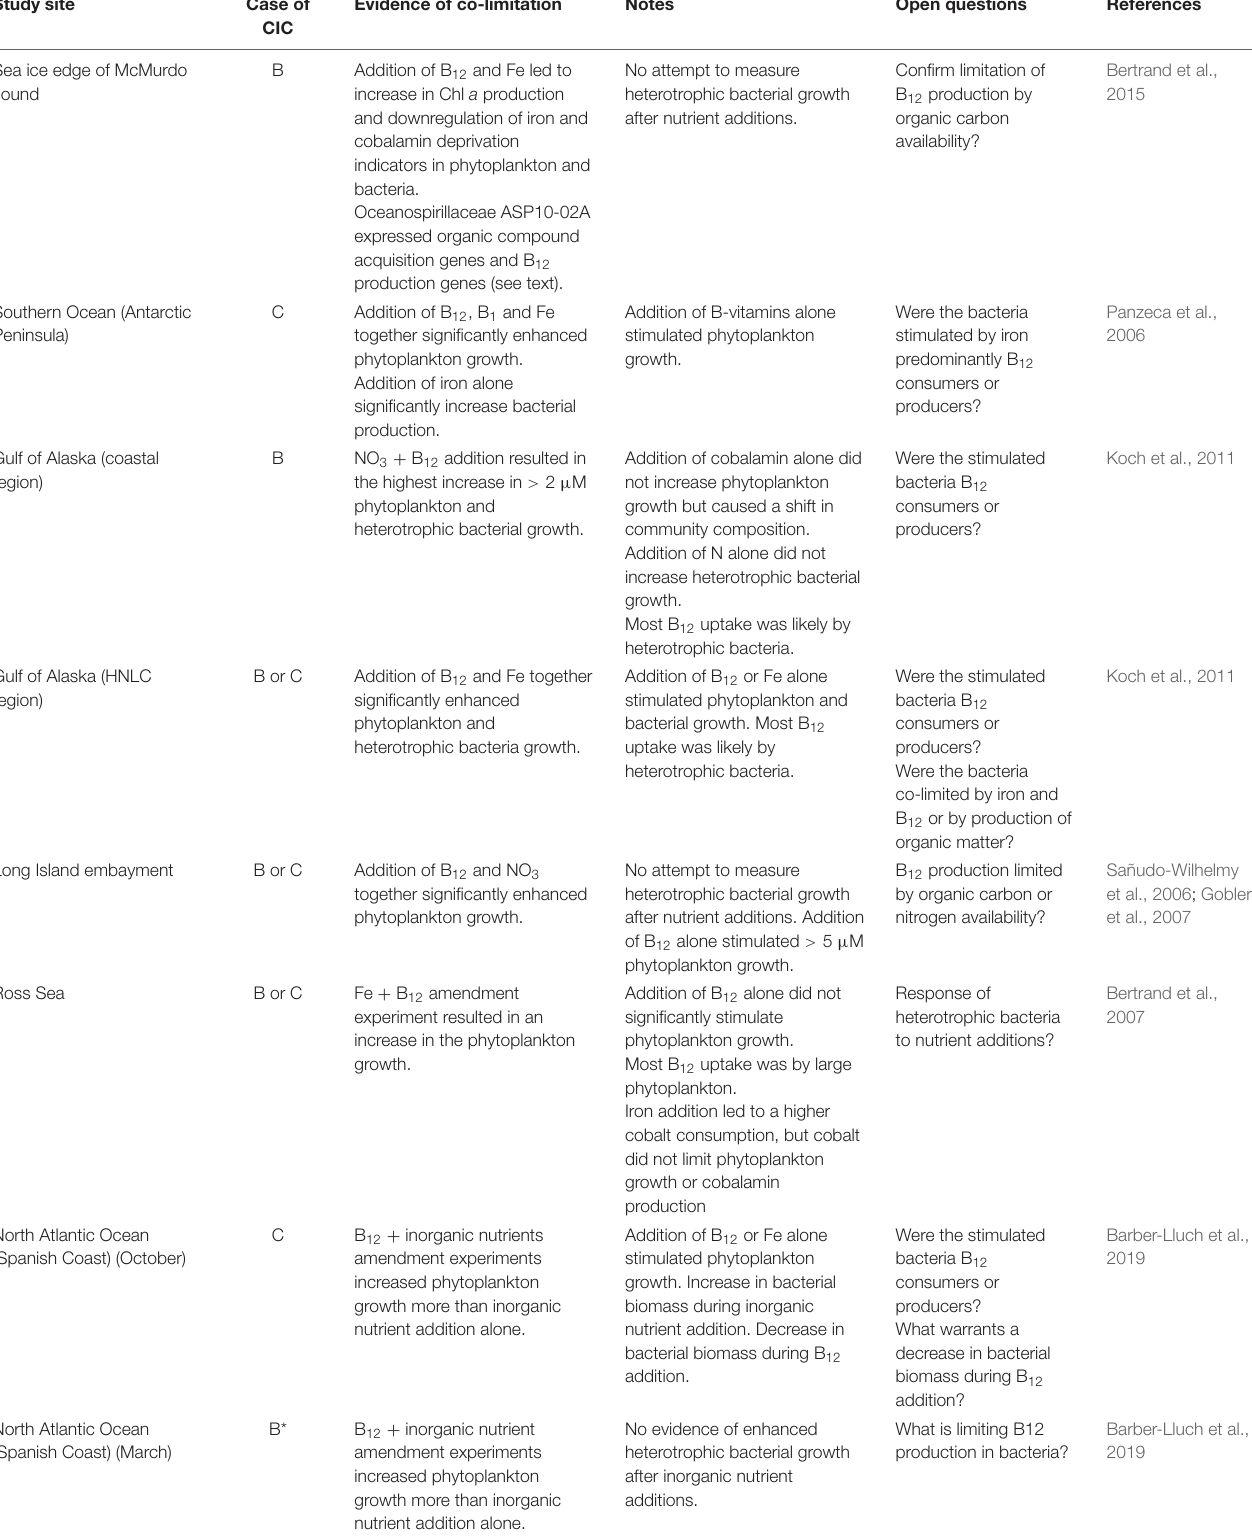
TABLE 2 | Instances of cobalamin community interaction co-limitation from